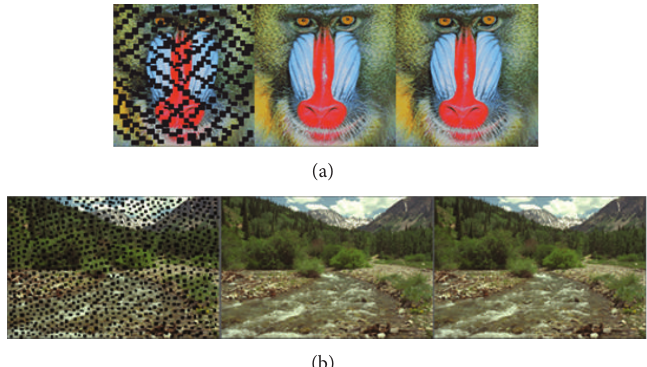
Figure 10: Subjective quality comparison between the proposed scheme and H.264/AVC Intra. QP is 24 for high quality. From top to bottom: mandrill (43% removal) and kodim13 (42% removal). From left to right: incomplete image with black blocks; reconstructed image by the proposed scheme; reconstructed image by H.264/AVC Intra. Please note that the proposed scheme reconstructs both highly textured images with 21.07% bit-rate saving. Please observe that in kodim13 (the first row) the mandrill eye can also be reconstructed on both sides.